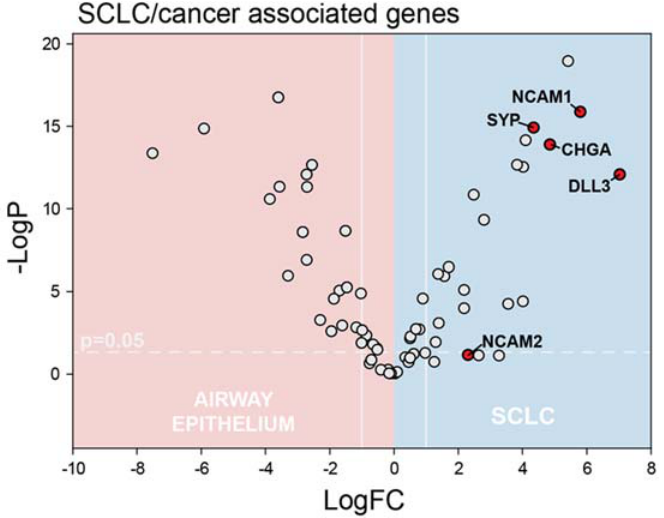
Figure1. Smallcelllung cancer(SCLC)samplesdisplayedelevated expression Figure 1. Small cell lung cancer (SCLC) samples displayed elevated expression of genes characteristically expressed at elevated levels in SCLC including NCAM1 , SYP , CHGA , and DLL3 (displayed data are summarized in Supplementary Table S2).